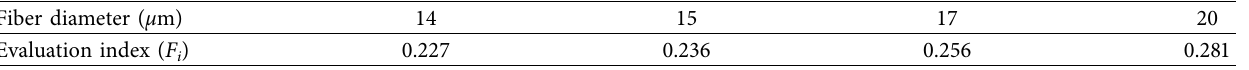
Table 8: Calculation results of evaluation index for diferent basalt fber diameters.